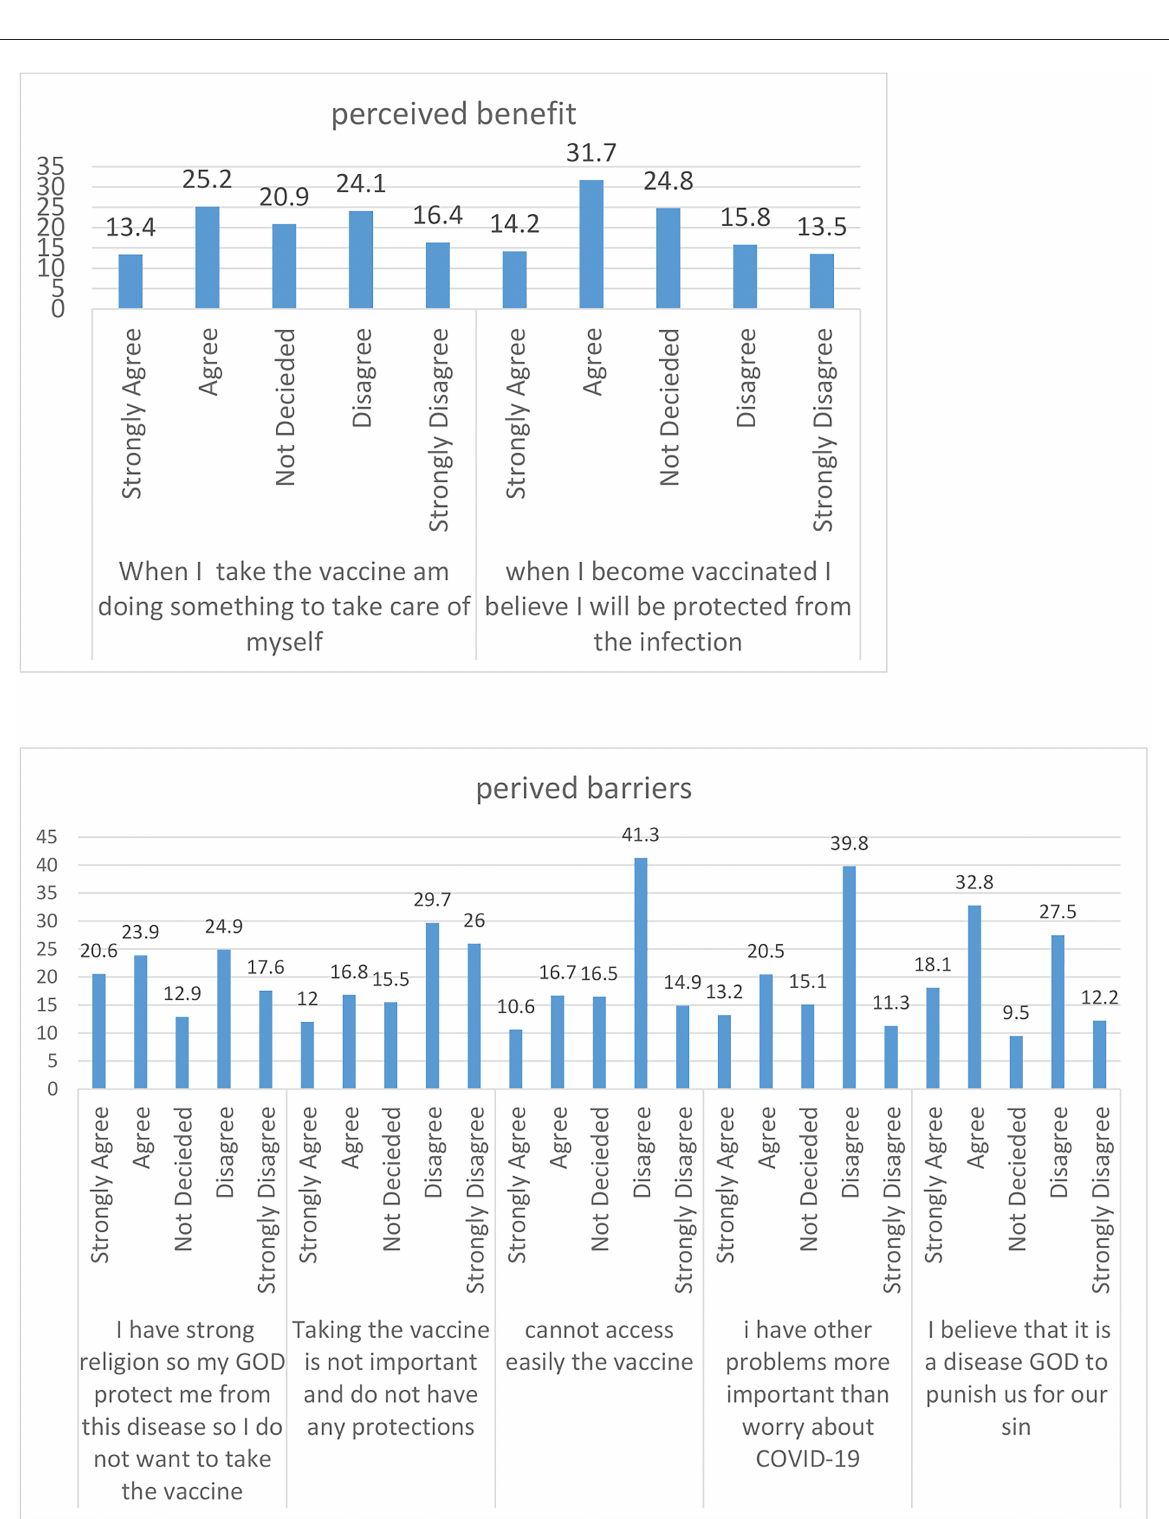
FIGURE2 Percentage of perceived barriers and benefits attitude toward COVID-19 of the study